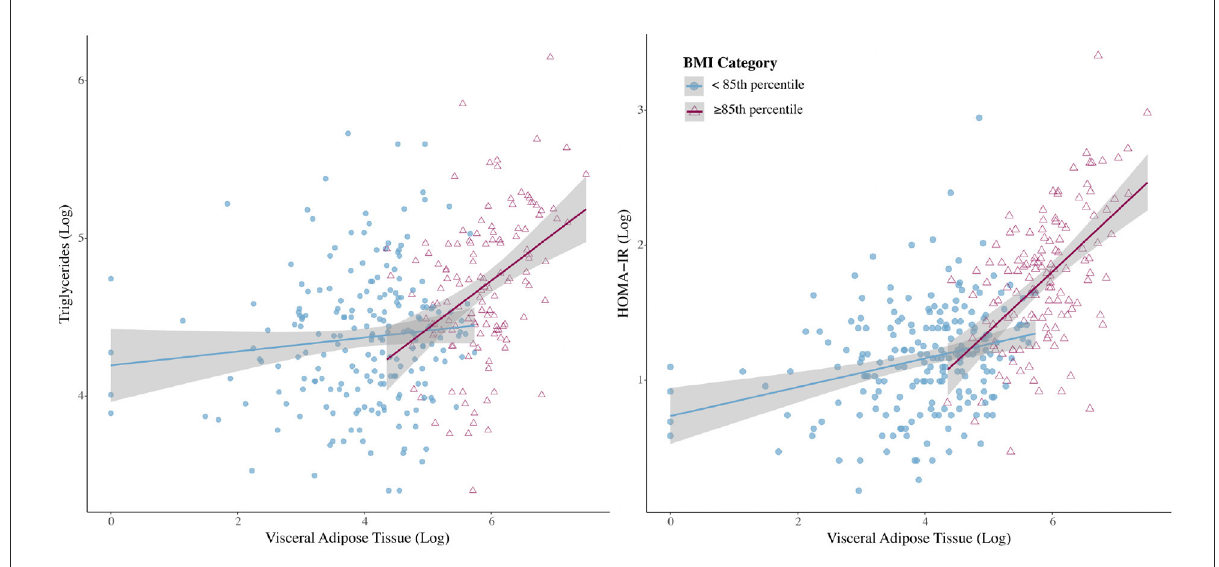
FIGURE1 Interactions with 95% confidence intervals between BMI category and visceral adipose tissue for outcomes of triglycerides and homeostatic model of insulin resistance (HOMA-IR).